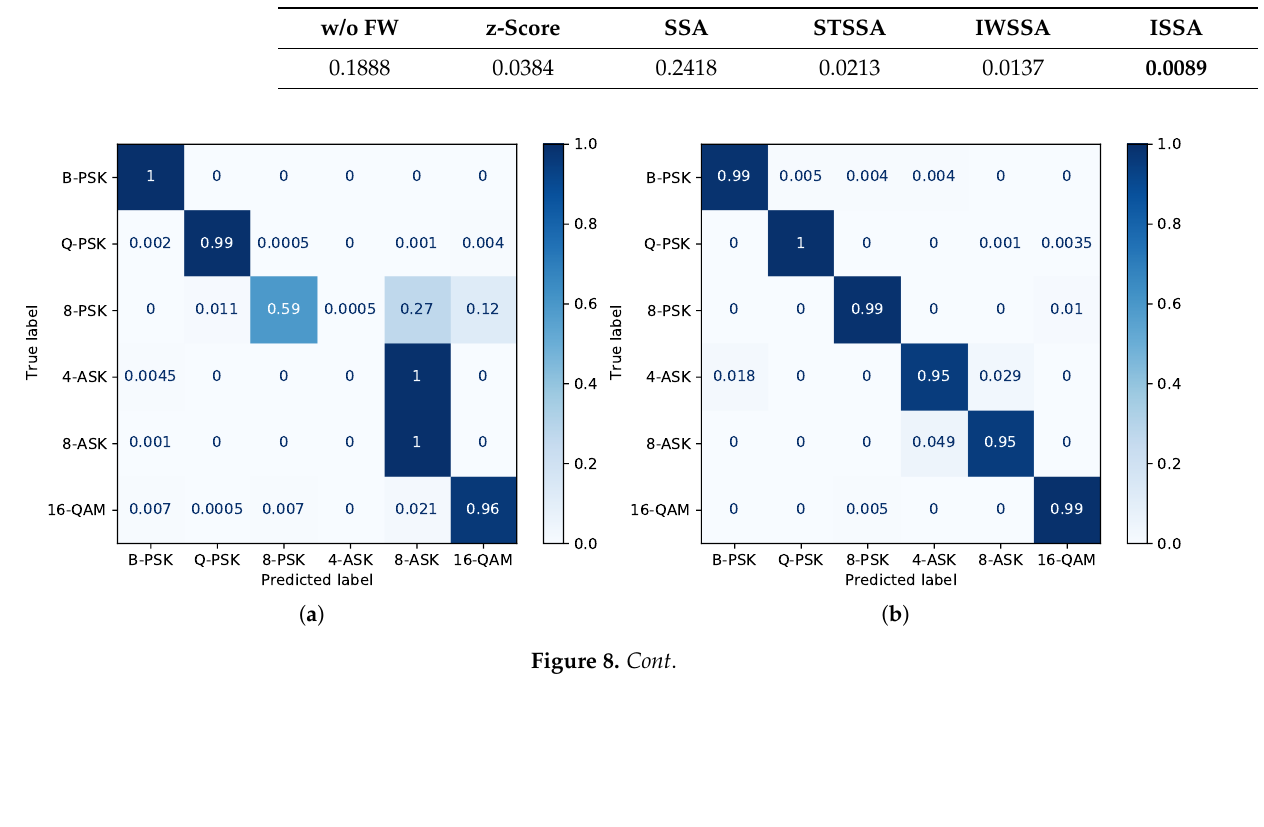
Table 5. Misclassification rate.